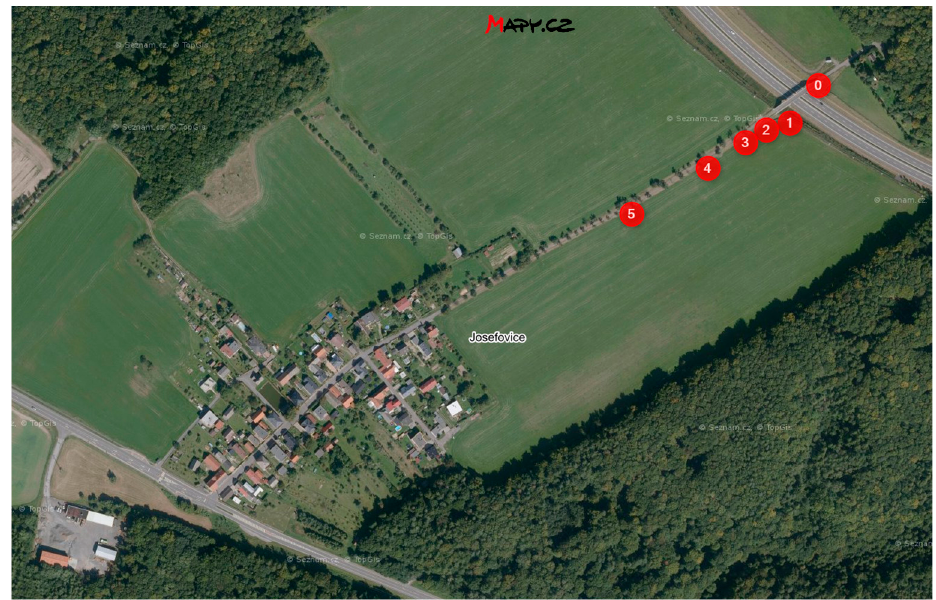
Figure 1. Locality near Hrabyn ě -Josefovice and bridge 11-134G (source: mapy.cz). Table 1. Distance of stands from the guide strip of the road. Stand 0 grass. The slope of the road cut can be seen in Figure 2.